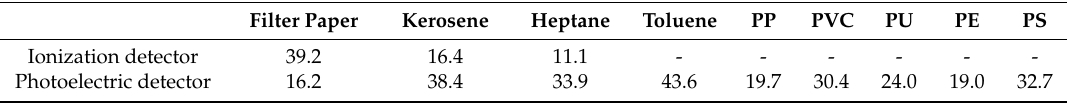
Table 1. Summary of obscuration thresholds (% / m) of filter paper, liquid fuels and polymer pellets (for the photoelectric smoke detector, the average value of all considered detectors is presented). Filter Paper